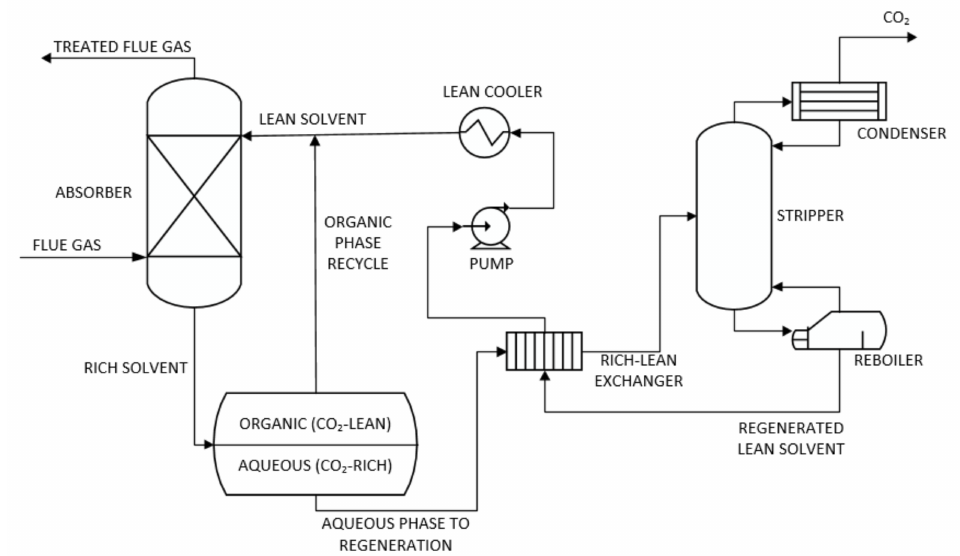
Figure 2. Typical flowsheet of a CO 2 capture process with a demixing